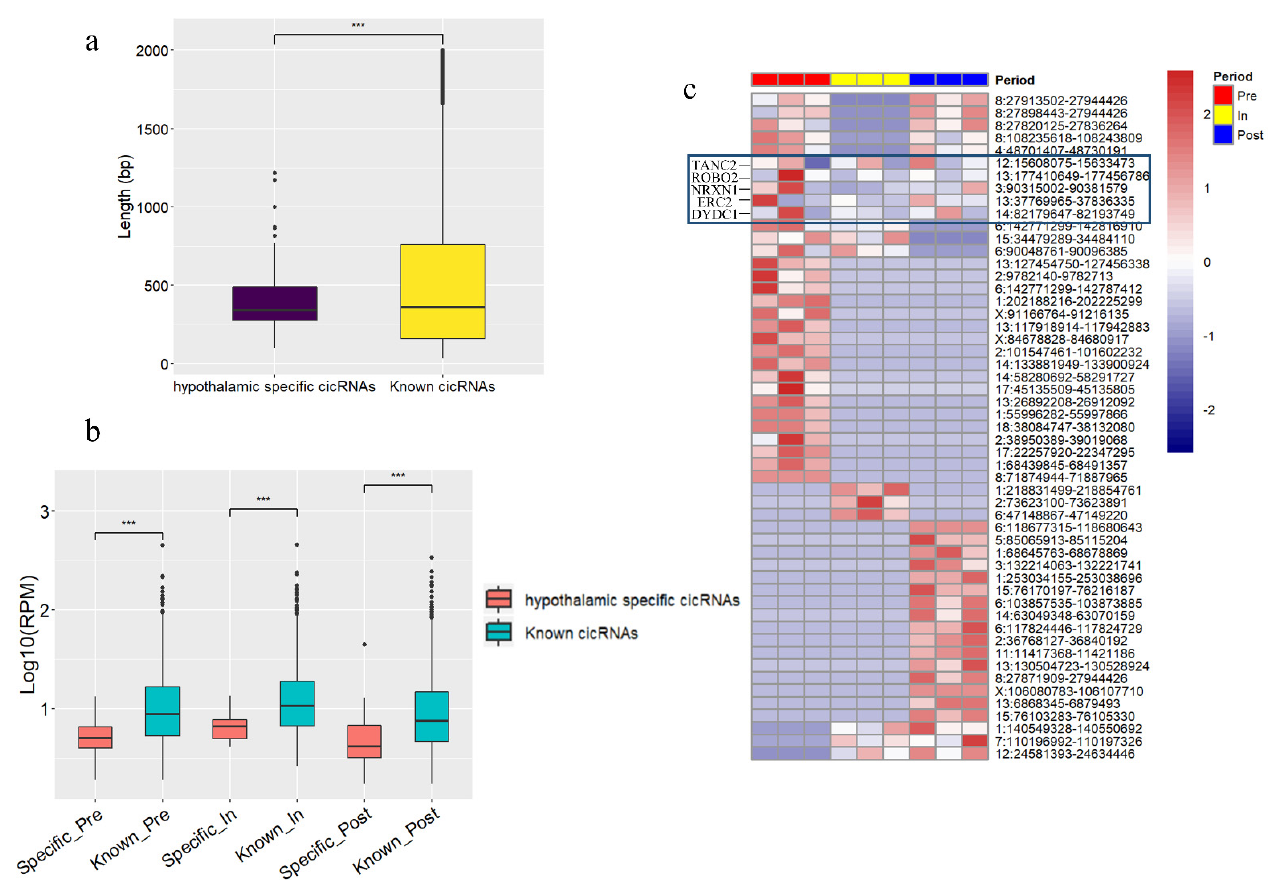
Figure 5. Analysis results of hypothalamus-specific circRNAs. ( a ) Length of tissue-specific circRNAs and known circRNAs. ( b ) Significant difference analysis between hypothalamus-specific circRNAs and known circRNAs. ( c ) The expression of hypothylamus-specific circRNAs in three stages, the blue box represents circRNAs and its parental genes without variation. *** p < 0.001.